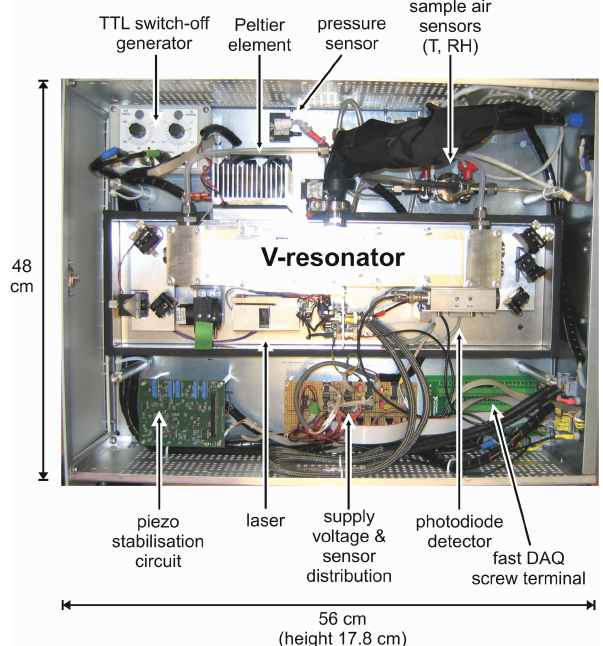
Fig. 7. Top view of the PeRCEAS NO 2 detector. The detector fits inside a 18cm-high 19 00 case whose front (here: left-hand side) can be opened. All electrical and gas connections are on its rear panel (here: right-hand